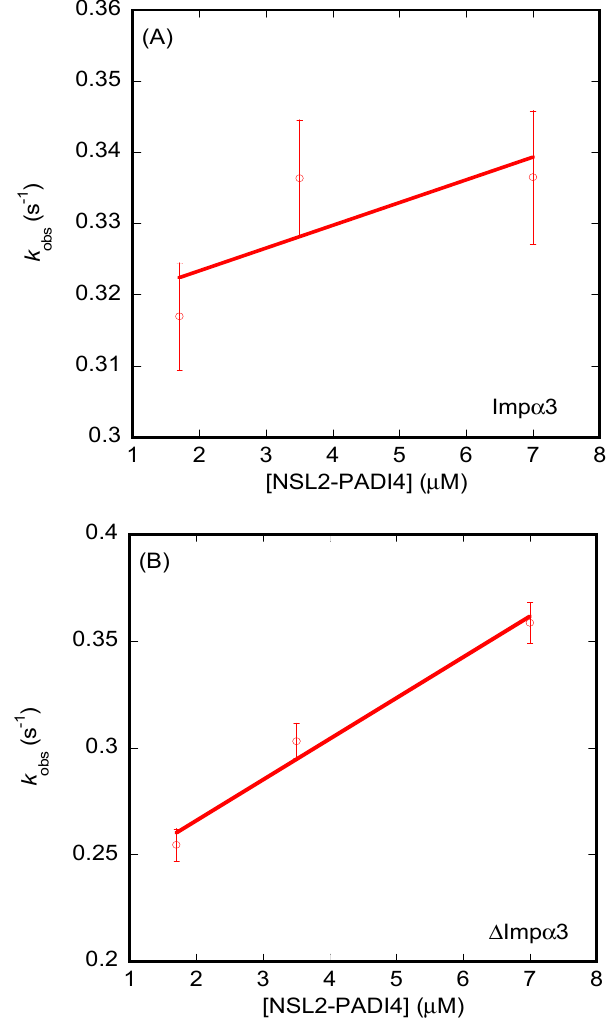
Figure 8. Binding of importin species to NLS2-PADI4 as monitored by BLI. ( A ) Pseudo-first-order plot of the binding of the peptide to Imp α 3 (Equation (6)). ( B ) Pseudo-first-order plot of the binding of the peptide to ∆ Imp α 3 (Equation (6)). The error bars in both panels are fitting errors to the exponentials of the sensorgrams. Experiments were carried out at 25 ◦